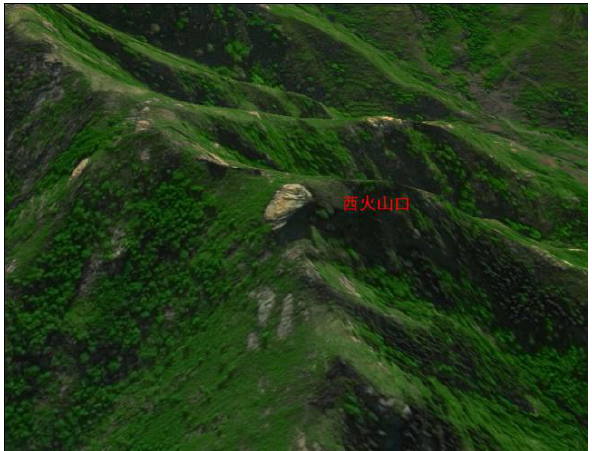
Figure 10. The crater in the western part of